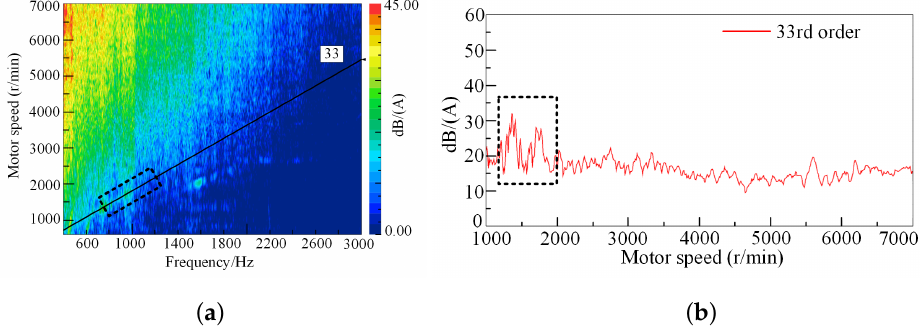
Figure 3. ( a ) Color map graph under the first gear acceleration condition; ( b ) 33rd order noise under the first gear acceleration condition.